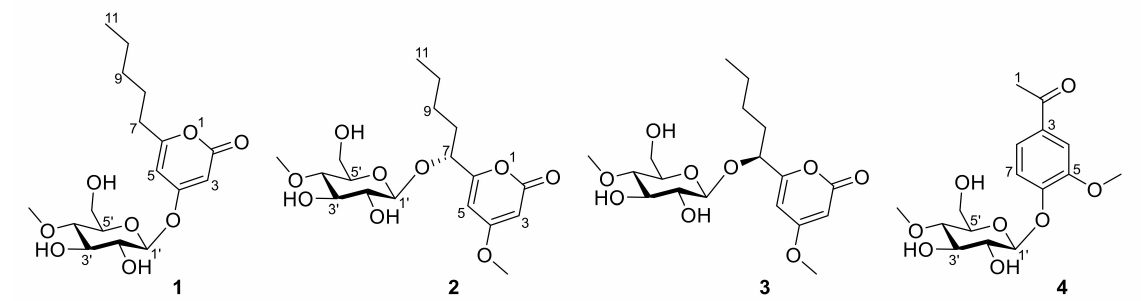
Figure 1. Structures of compounds 1 – 4